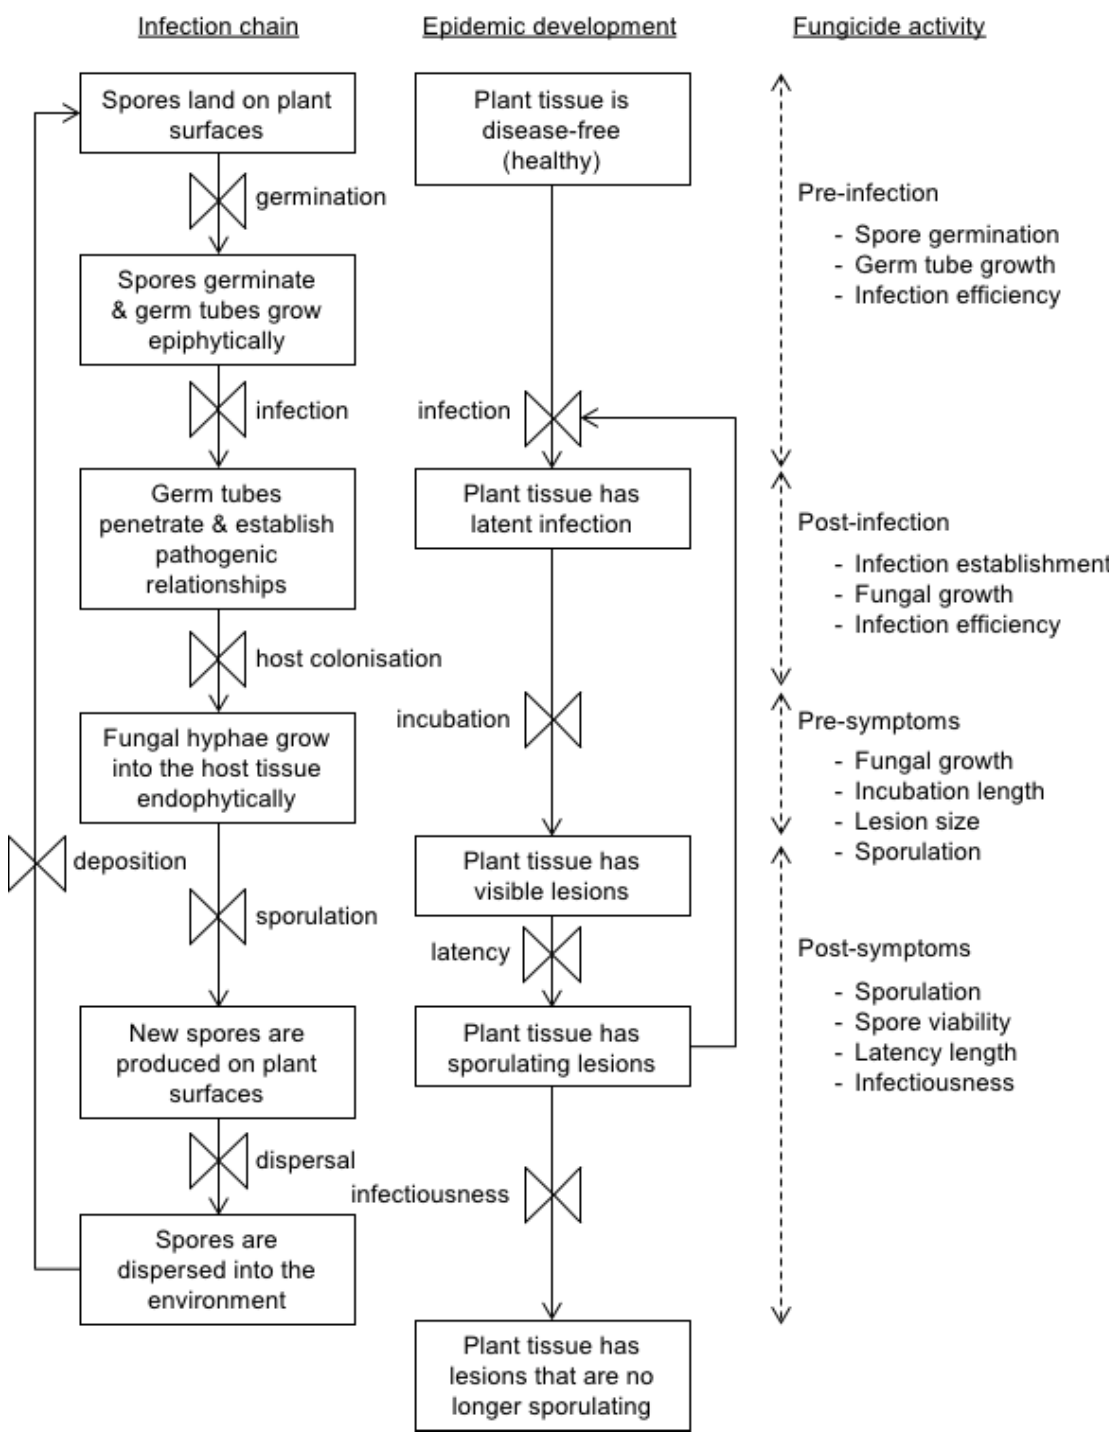
Figure 1. Relationships between steps of the infection chain of plant pathogenic fungi, epidemic development, and fungi- cide activity. The figure uses systems analysis symbols (Leffelaar and Ferrari, 1989): boxes are state variables; arrows show flux and direction of states; and valves in a flux are